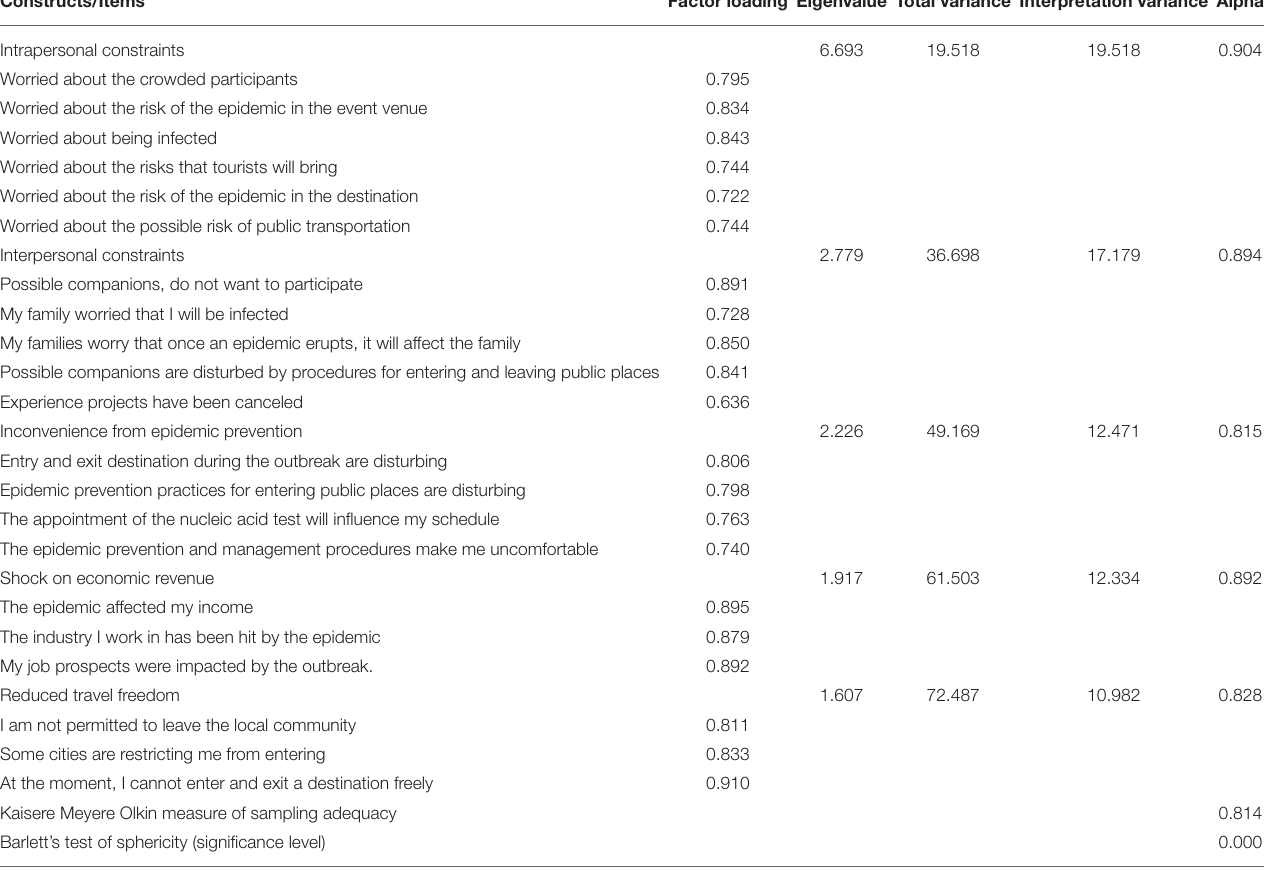
TABLE 1 | Results of exploratory factor analysis (EFA) on data from the first round survey. Constructs/Items